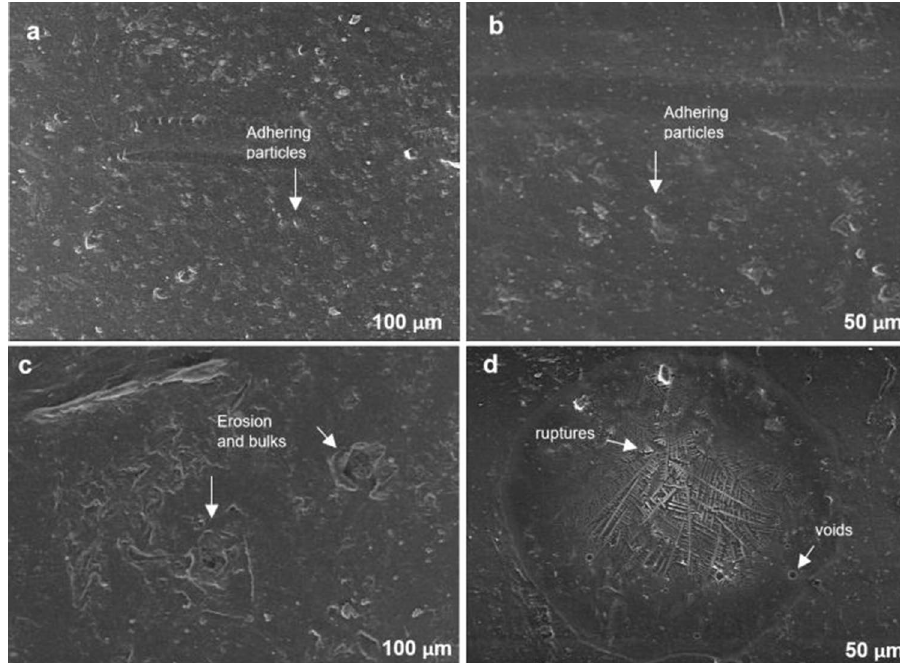
Fig. 5 Scanning Electron Microscopy. a and b: new LDPE without treatment; c and d: aged LDPE * without